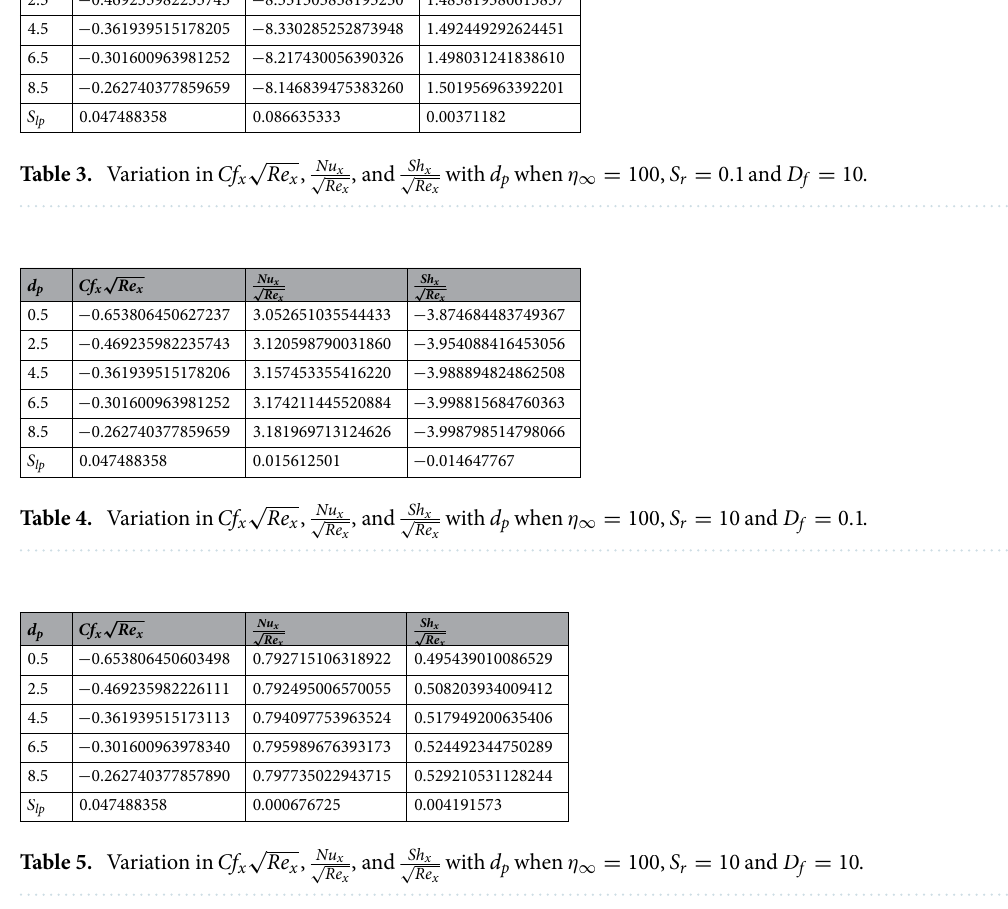
Table 5. Variation in Cf x √ Re x , Nu x